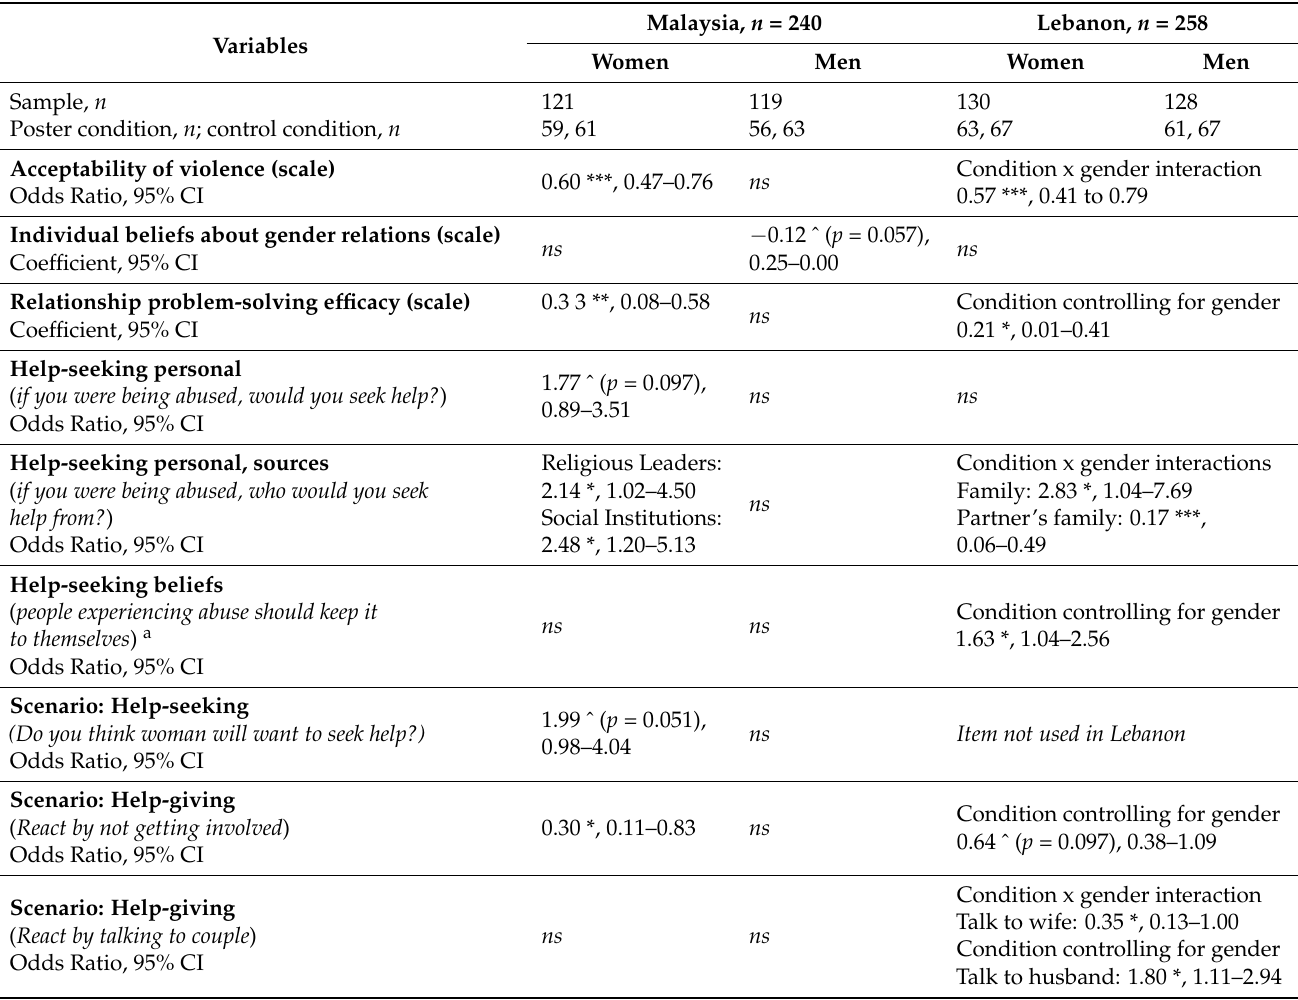
Table 6. Poster testing